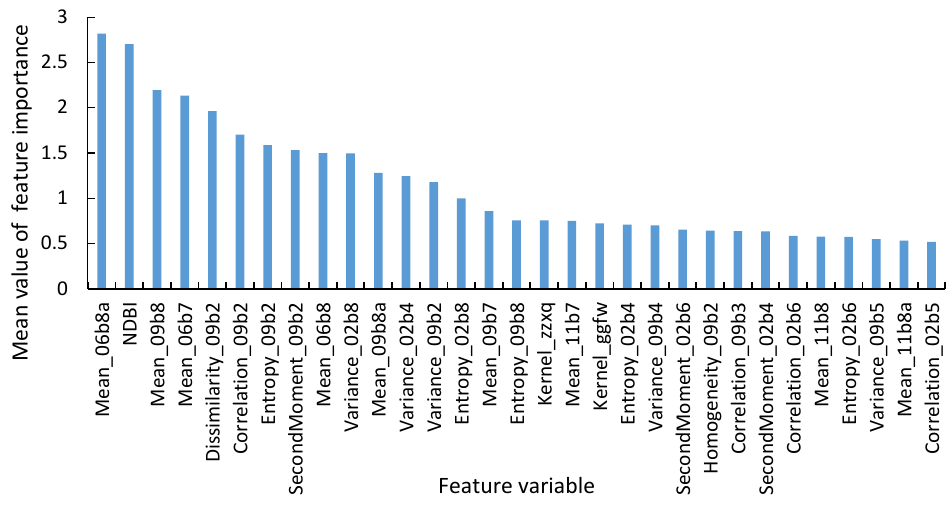
Figure 7. Feature importance ranking for the optimal feature combination.